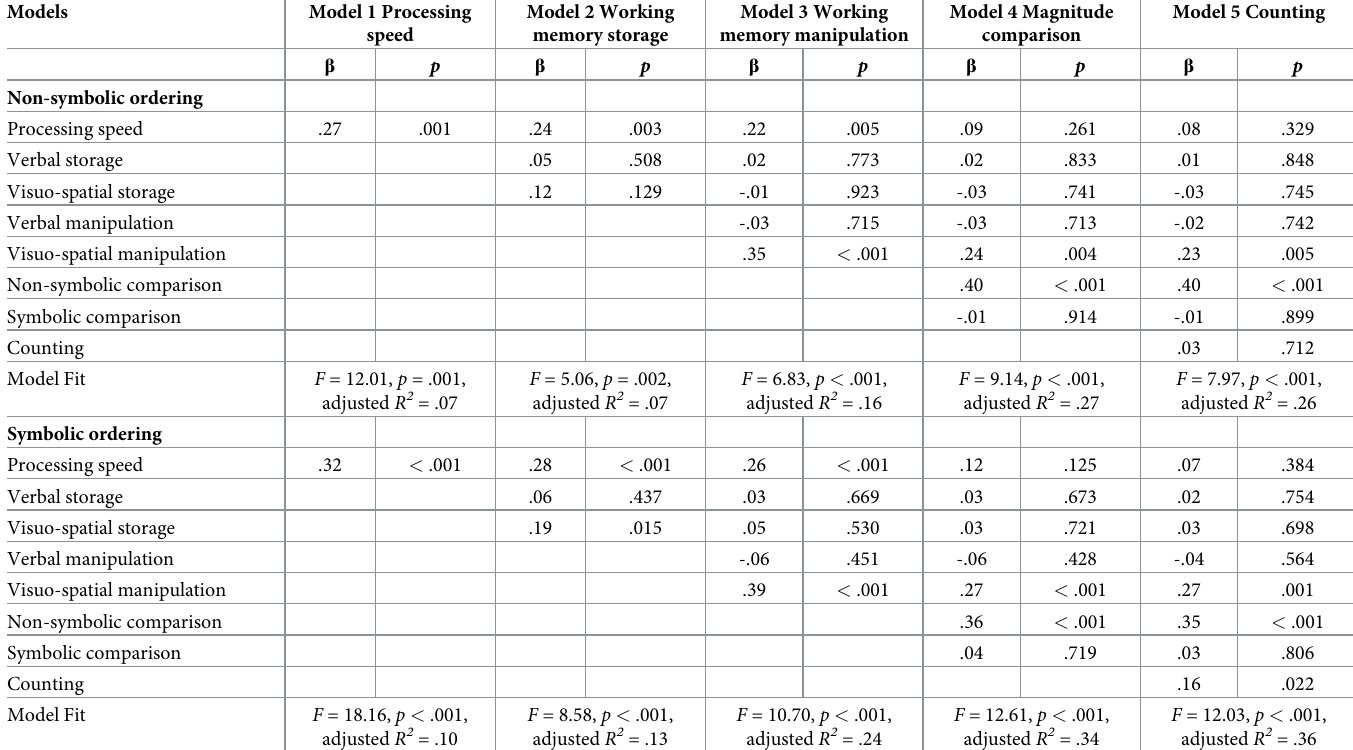
Table 4. Hierarchical linear regression analyses predicting performance in non-symbolic and symbolic ordering in Grade 1 by processing speed, working memory storage and manipulation, as well as non-symbolic and symbolic numerical